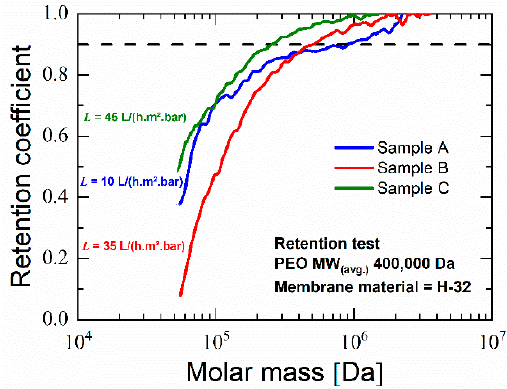
Figure 11. Retention coefficient of membrane manufactured using sandwich-type samples vs. molar mass.